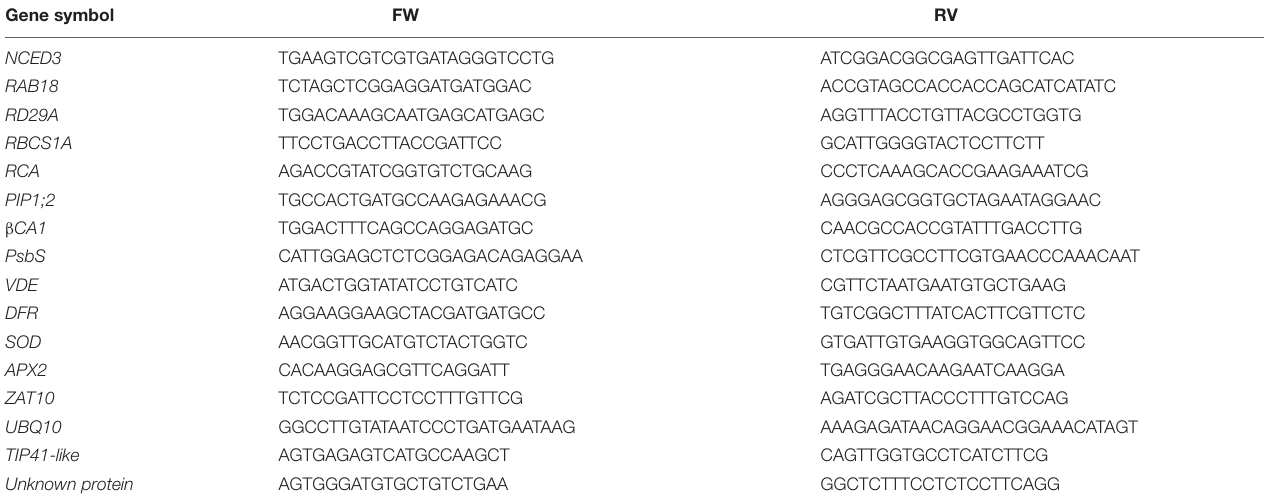
TABLE 1 | List of specific primers forward (FW) and revers (RV) used for gene expression analysis. Gene